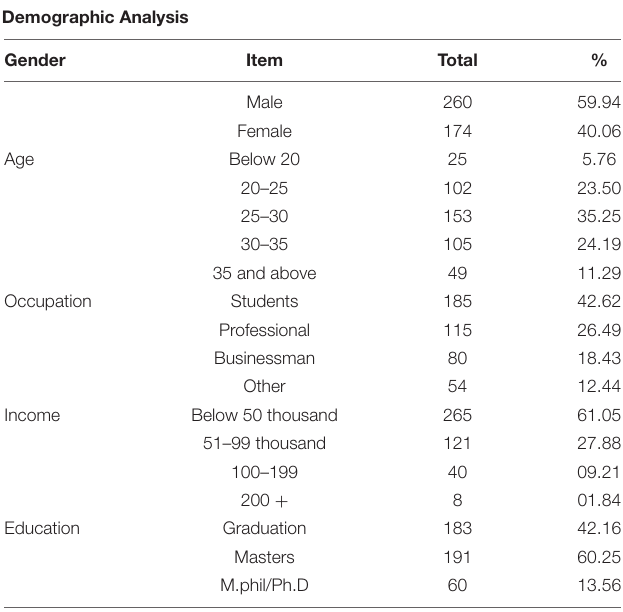
TABLE 2 | The demographic profile of the